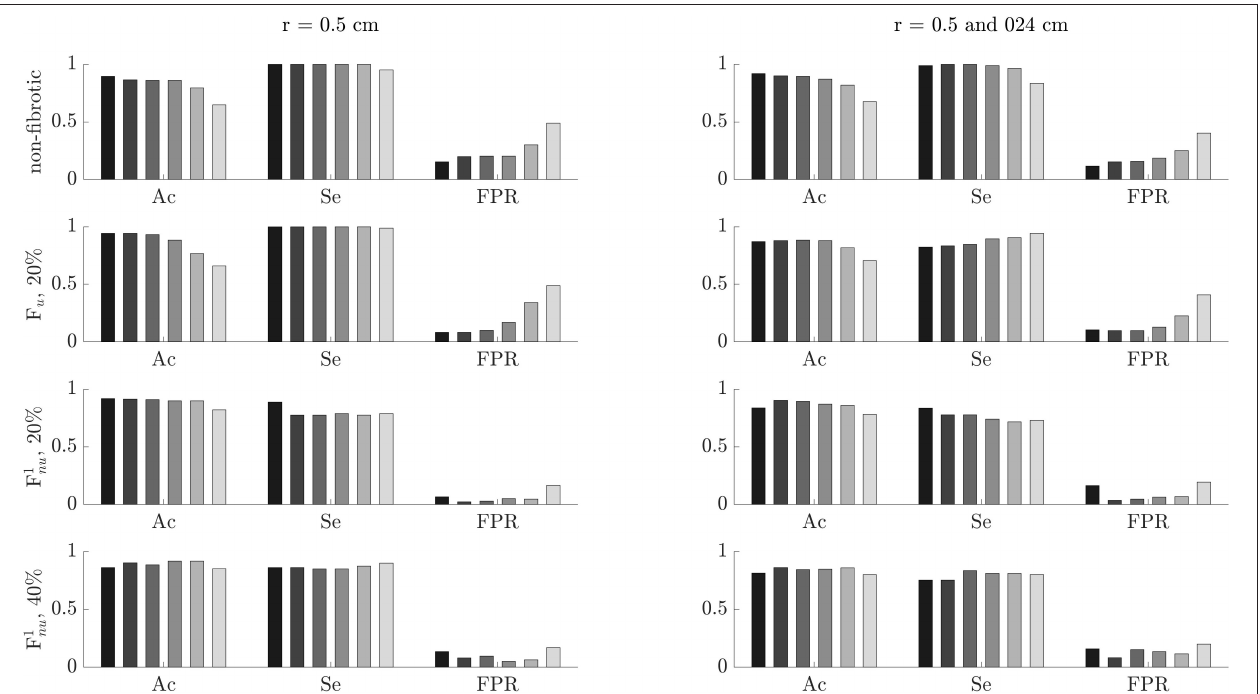
FIGURE 10 | Accuracy (Ac), sensitivity (Se), and false positive rate (FPR) for different noise levels. The color code from dark to light gray is representative of no noise and noise with signal-to-noise ratio (SNR) values of 20, 15, 10, 5, and 0 dB.